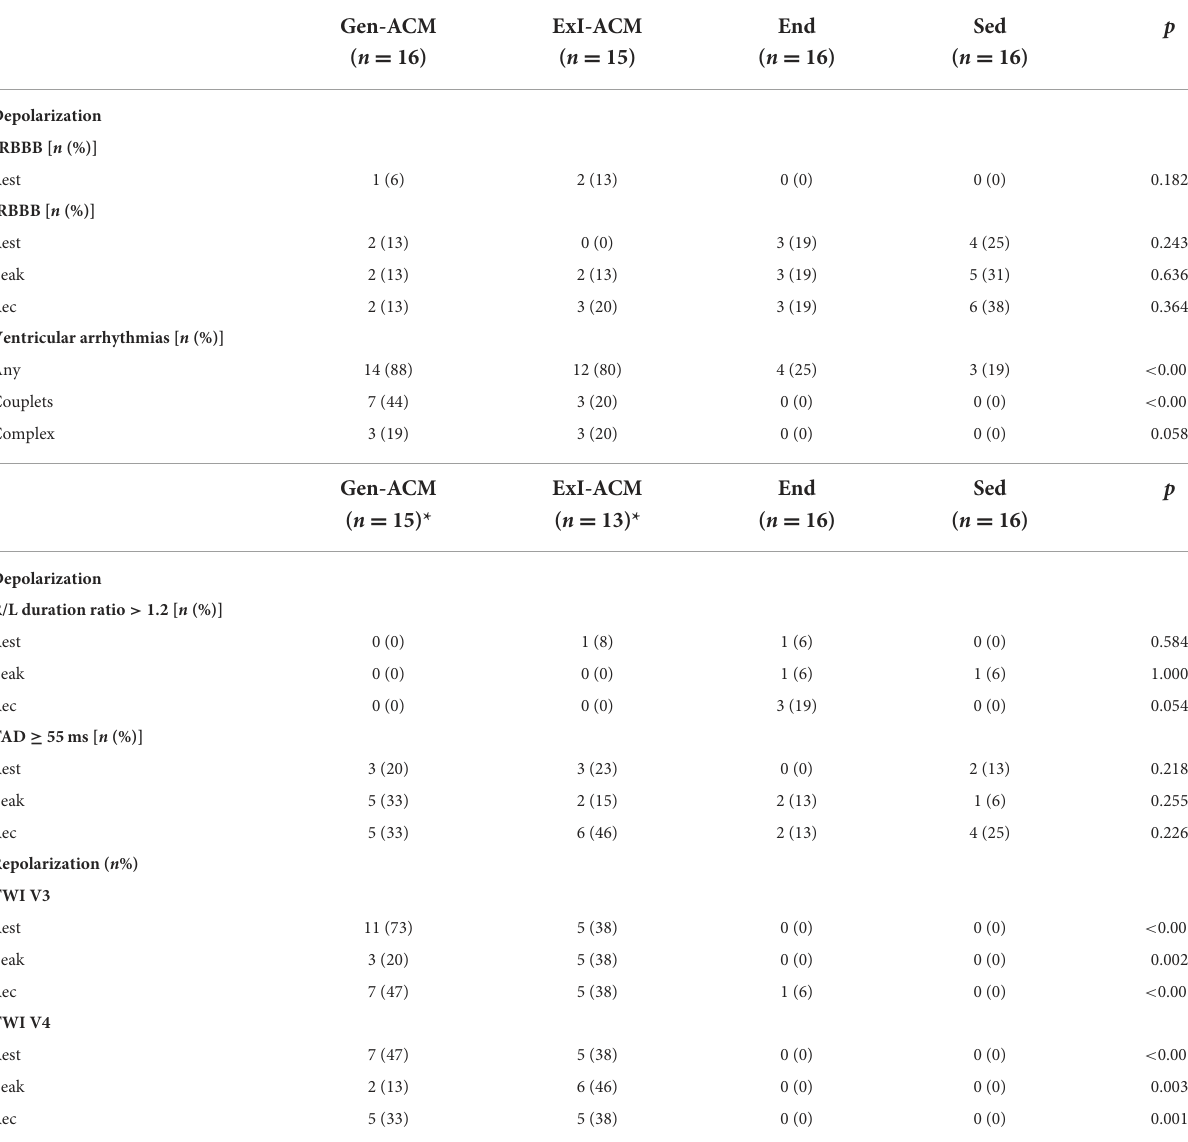
TABLE 2 Frequencies of ECG